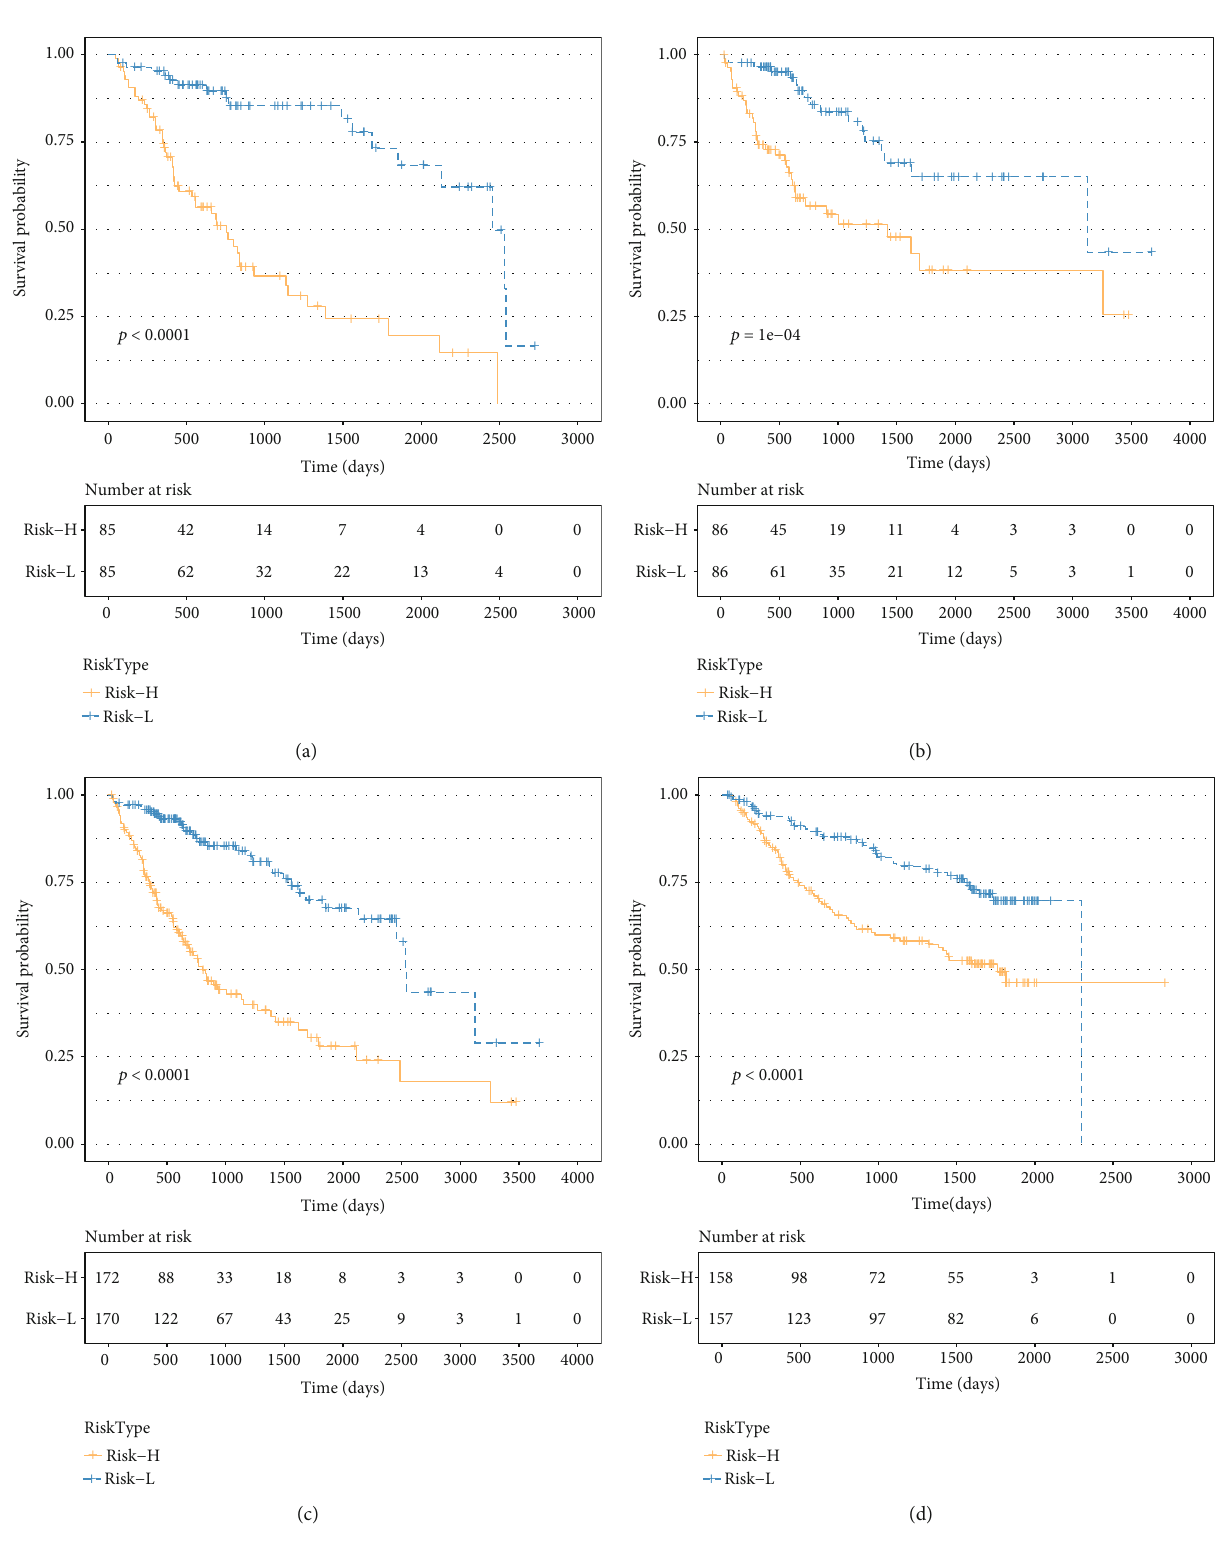
Figure 3: Kaplan – Meier survival analysis of the HCC samples based on the nine-IRGP signature. Kaplan – Meier curves show the survival time of the (a) training, (b) testing, (c) TCGA, and (d) veri fi cation